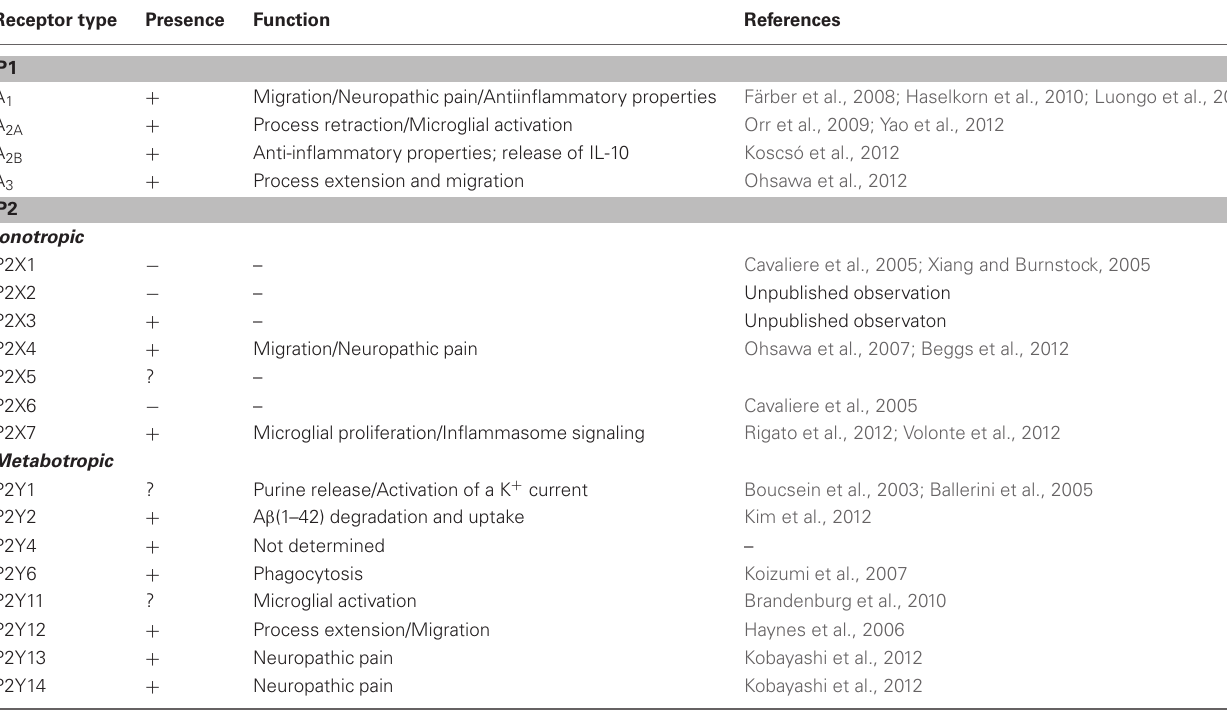
Table 1 | Expression and function of purinergic receptors on microglia. Receptor